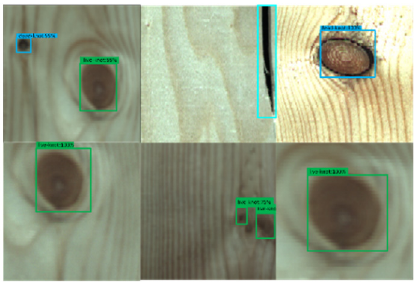
Figure 9. Recognition results based on the ResNet + SSD algorithm.